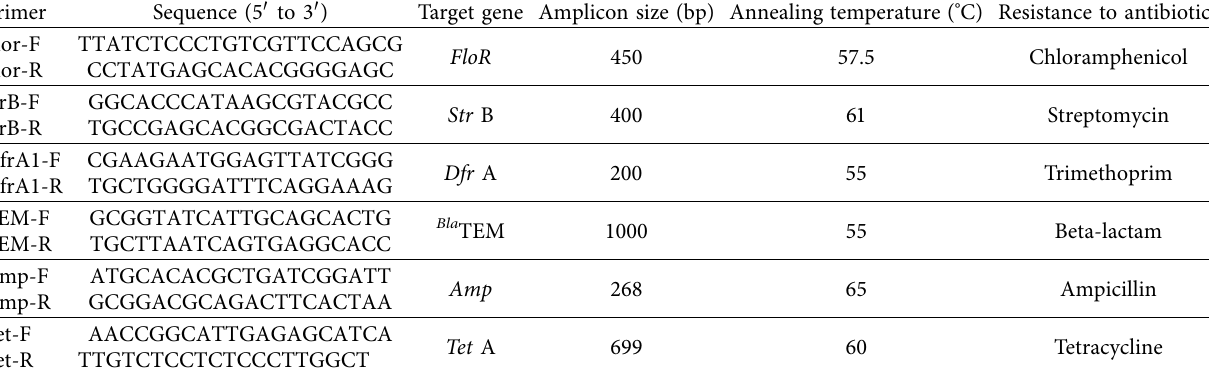
Figure 1: Sampling site in Embu County. Table 1: List of primers for antibiotic resistance